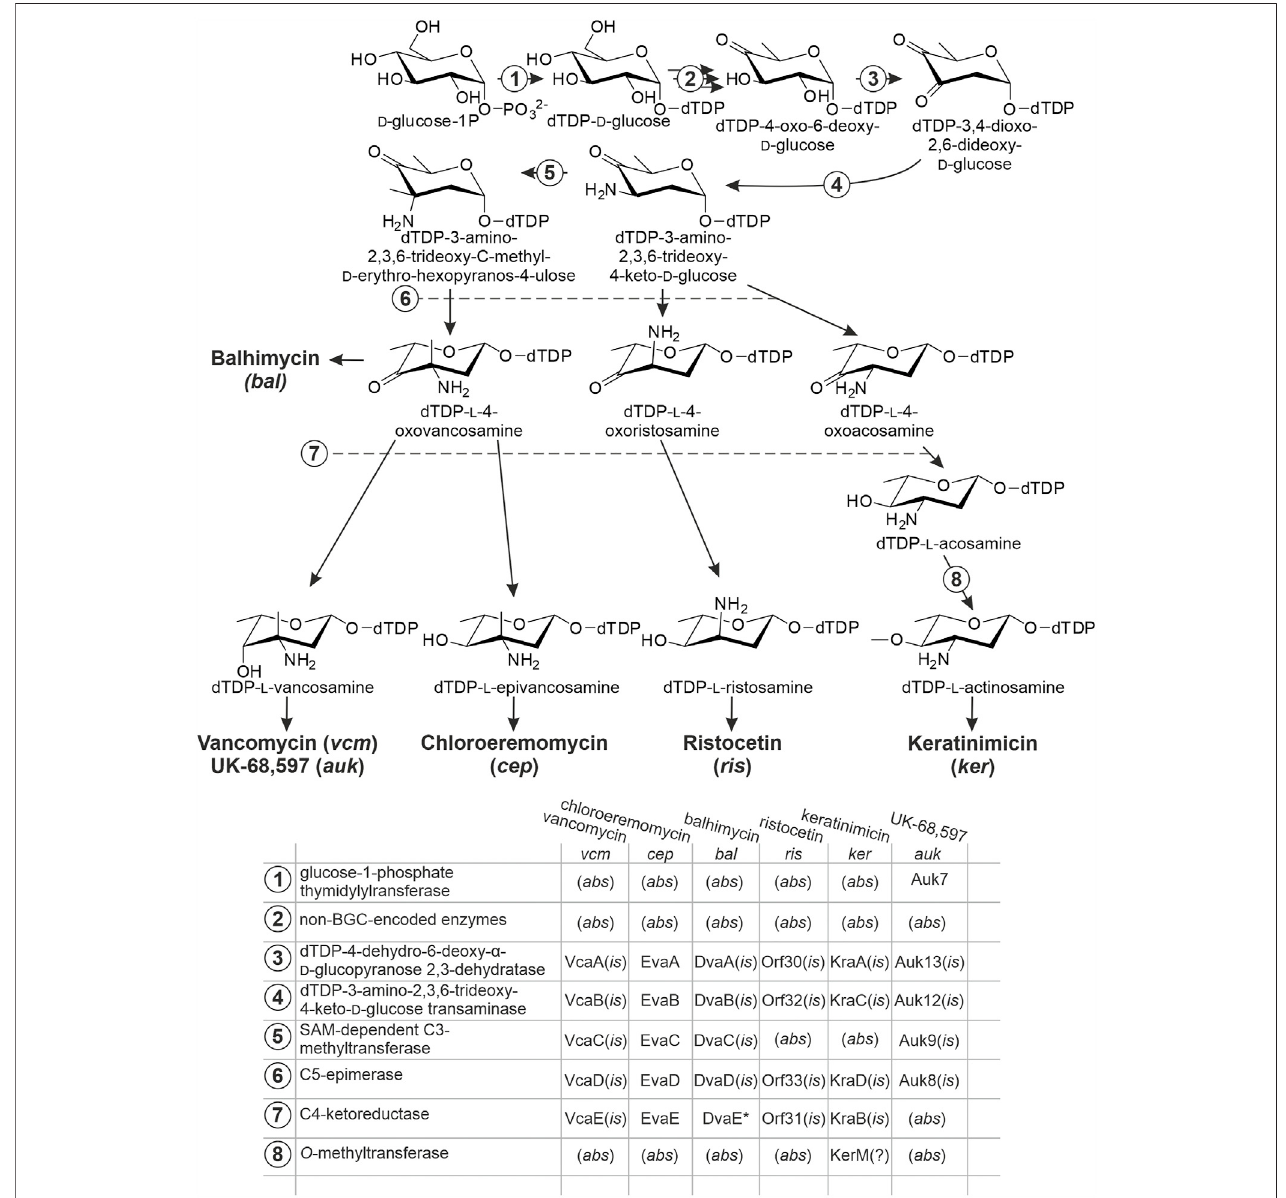
FIGURE 1 | Enzymes involved in the biosynthesis of non-conventional aminosugars, decorating aglycones of some dalbaheptides. Biosynthetic pathway of L- epivancosamineserves asamodel, sinceEvaA-B-C-D-E,codedwithin cep ,aretheonlyenzymesthatwerestudiedexperimentally. Functionsofallotherenzymes were assigned by in silico comparison ( is ); ( abs ) indicates that the corresponding gene is absent from BGCs; (?) indicates that the assigned function is speculative, having no experimentally investigated prototype. Asterisk at DvaE indicates that this protein is mutated. Refer to the main text for more details.